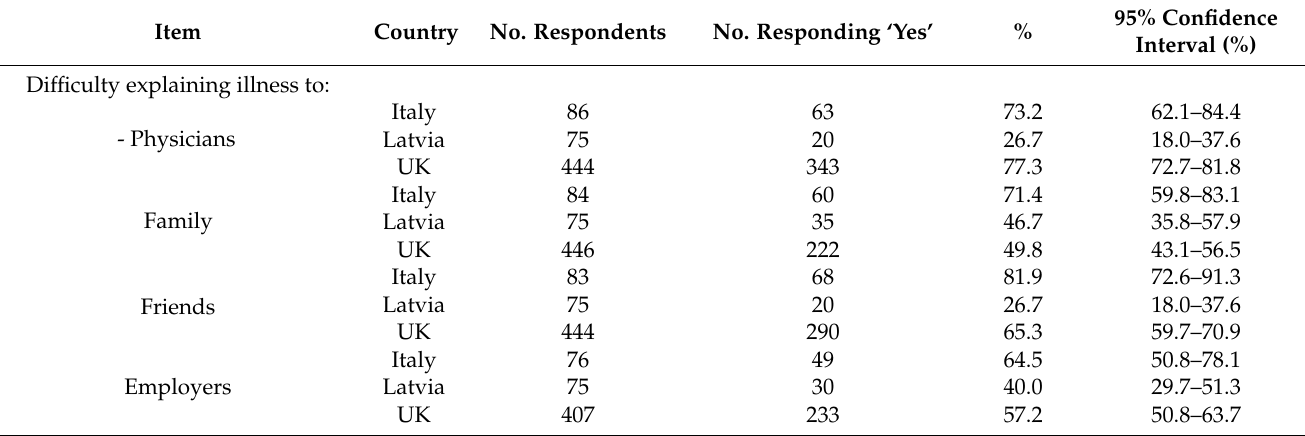
Table 7. Difficulty explaining the illness.